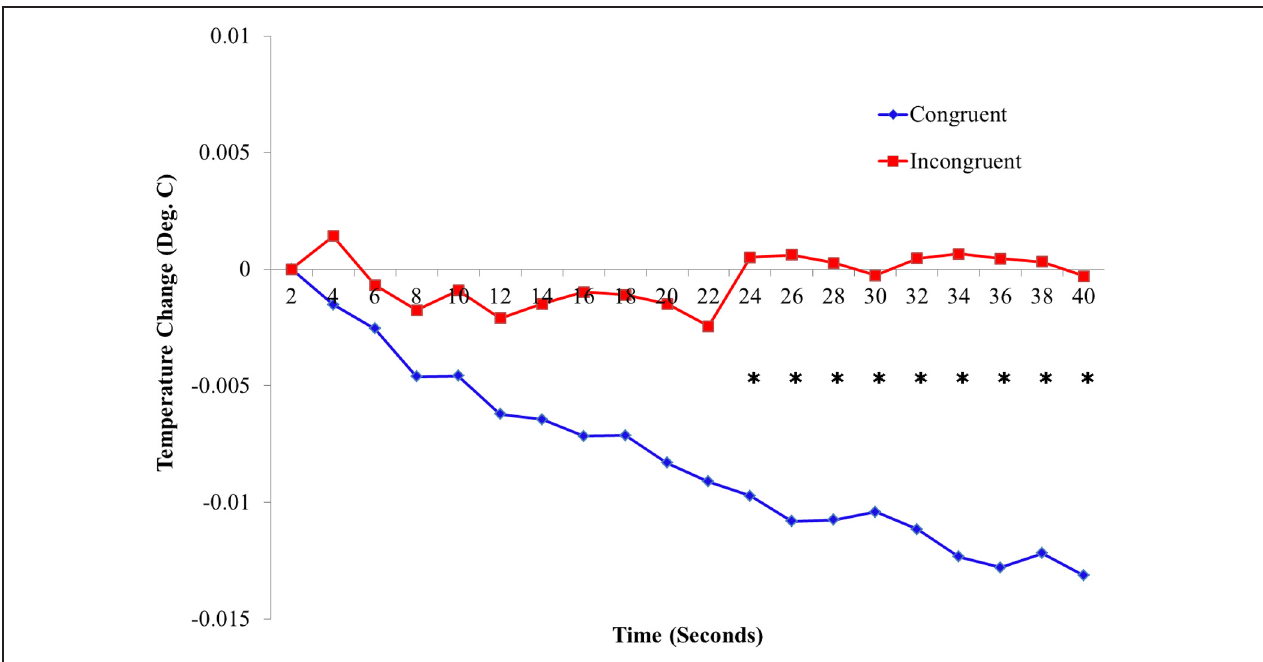
FIGURE 5 | Temperature time course data. Temperature changes across four locations during 40s of stroking for all conditions. Blue and Red lines represent temperature changes between congruent and both incongruent